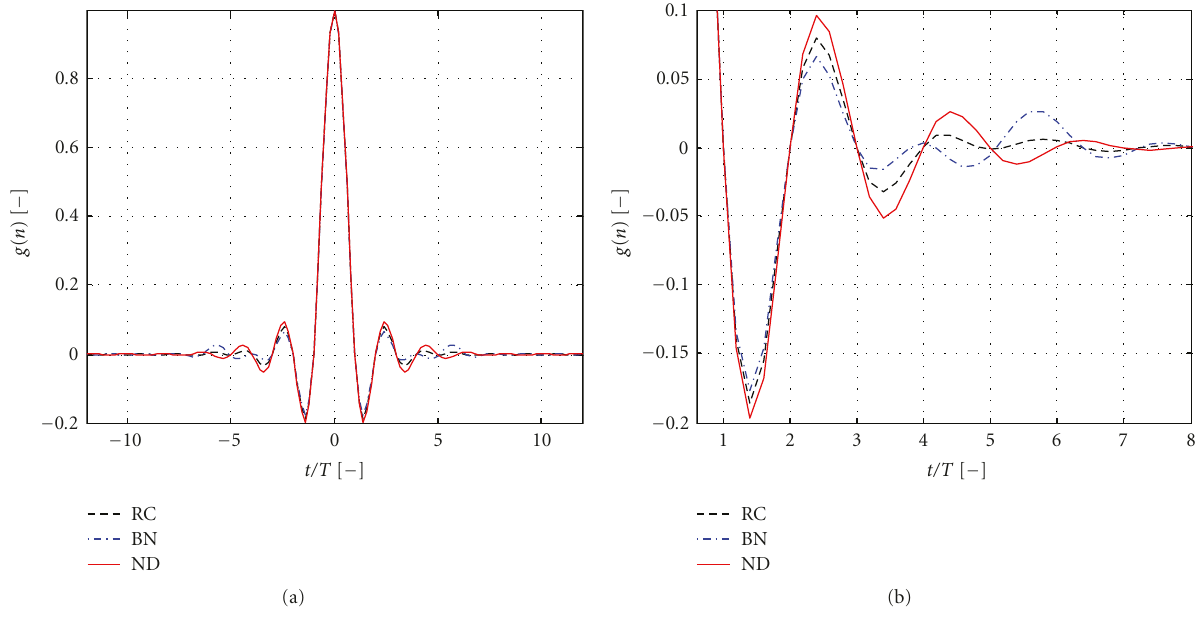
Figure 10: Normalized impulse responses of the cascade of transmitter and receiver RC filter (RC); B -filter (BN); Nyquist δ -filter (ND). α = 0 . 284; G D = 2 × 6; N = 5; N O = 2 ×